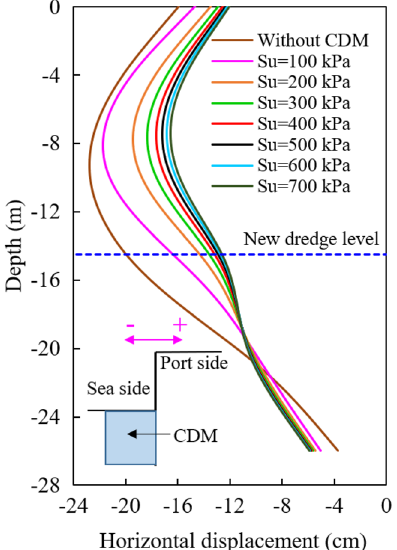
Fig. 13 Horizontal displacement of the sheet pile wall with the different undrained shear strength of CDM (the Coalinga